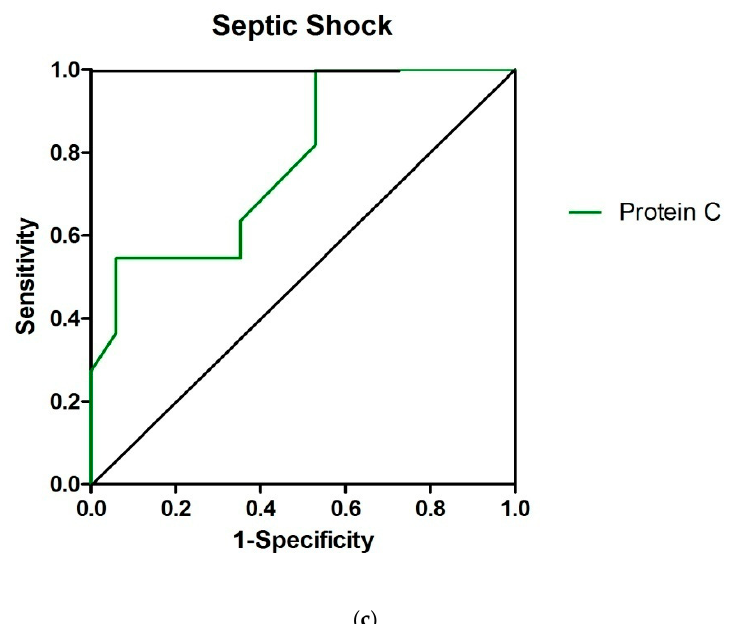
Figure 1. Receiver operating characteristic curves for Inteleukin 10 ( a ), Antithrombin III (ATIII) ( b ) and Protein C ( c ) in sepsis, severe sepsis and septic shock, respectively; the areas under the curves, indicating the predictive value of each variable in the sense of patient temporary clinical deterioration or improvement, were 0.72 ([95% confidenceinterval] 0.51–0.87), 0.74 (0.62 − 0.86) and 0.78 (0.60–0.95), respectively.